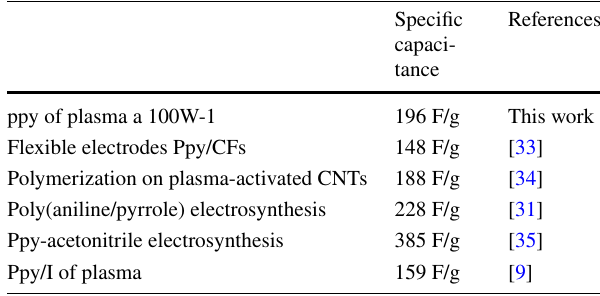
Table 2 Comparison of the electrochemical capacitor between the ppy polymerization presented in this work and already published reports